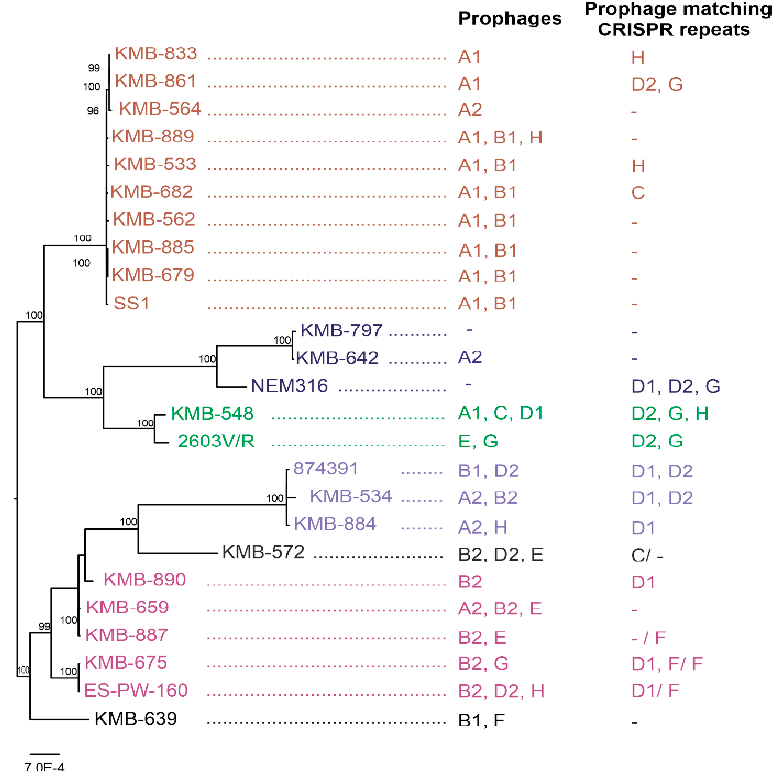
Figure 1. Distribution of prophages belonging to the groups A-H and CRISPR repeats complementary to these prophages in 20 sequenced group B Streptococcus (GBS) strains. Dendrogram based on comparison of 100 loci was used for genome similarity estimation with one reference genome per clonal complex (CC): SS1 (CP010867.1), NEM316 (AL732656.1), 2603V/R (NC_004116.1), 874,391 (CP022537.1), ES-PW-160 (LCVT00000000.1). Strains clustered according to CCs: CC-1 (brown), CC-12 (red), CC-17 (violet), CC-19 (green), CC-23 (blue), and sequence type (ST) not involved in CC (black). Table 1. Prophages in GBS sequenced genomes.